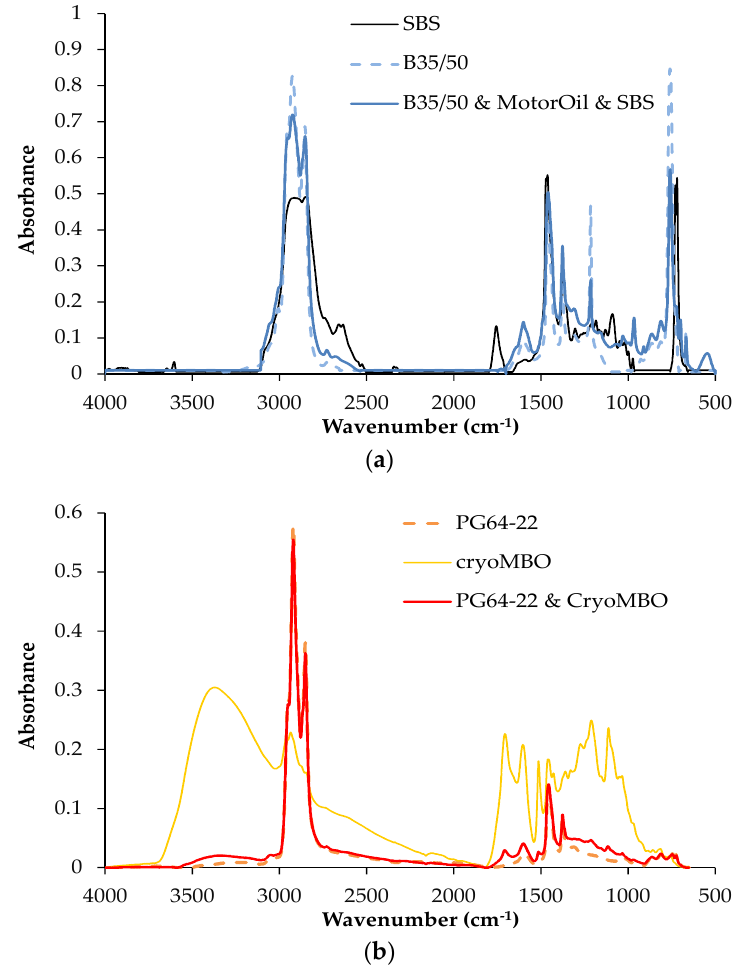
Figure 1. Fourier transform infrared (FTIR) spectra results of: ( a ) styrene-butadiene-styrene (SBS) elastomer, conventional bitumen (B35/50) and modified asphalt binder B35/50 & MotorOil & SBS; ( b ) Rubber modified bio-oil (cryoMBO), bitumen PG64-22 and modified asphalt binder PG64-22 & cryoMBO (adapted from Peralta et al. [6], @ AAPT, 2014).